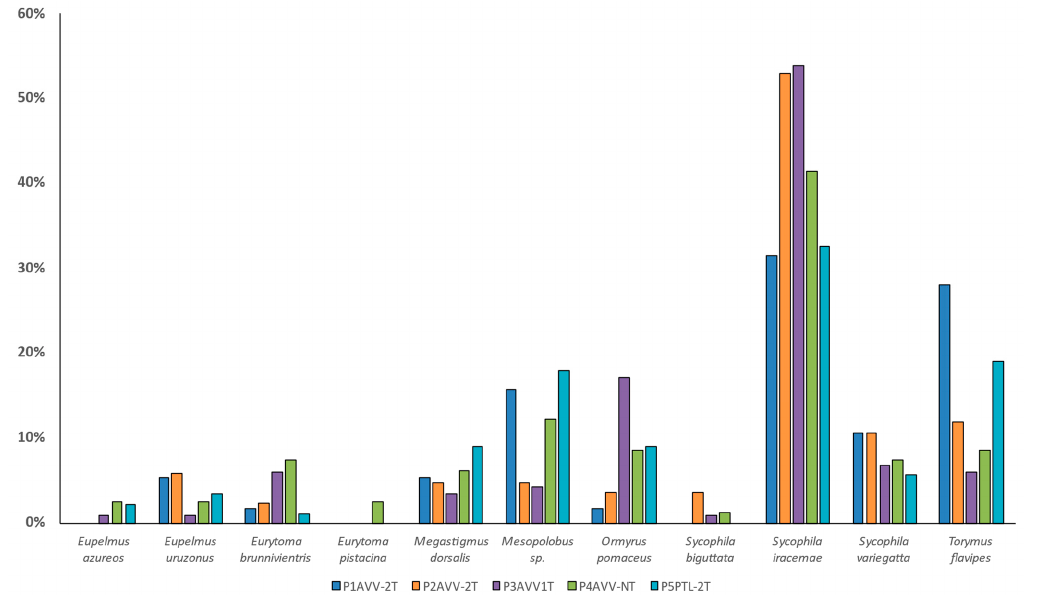
Figure 8. Relative abundance of parasitoids identified in 2018 in chestnut orchards located in Arcos de Valdevez (AVV) and Ponte de Lima (PTL), with one (1T), two (2T) or no treatment (NT) of T. sinensis . 3.5. Establishment of T. sinensis Populations in Minho T. sinensis was present in chestnut galls throughout the year and overwintered in dead galls. Adults emerged in 2019 between February and March (Figure 9). The establishment of T. sinensis populations in the orchards with two parasitoid releases in 2016 and 2017 was assessed by recording the emergence of T. sinensis adults in 2019 from summer galls harvested in 2018. Figure 9 shows evidence that the highest number of hatched T. sinensis insects was recorded in the orchards of Arcos de Valdevez located in Rio Cabr ã o (P1) and T á vora (P2). The parasitism rate varied between 0.0205% in the orchards of Arcos de Valdevez and Salvador not treated with T. sinensis (P4) and 0.5044 % in the orchard of Rio Cabr ã o (P1), with two treatments of T. sinensis .